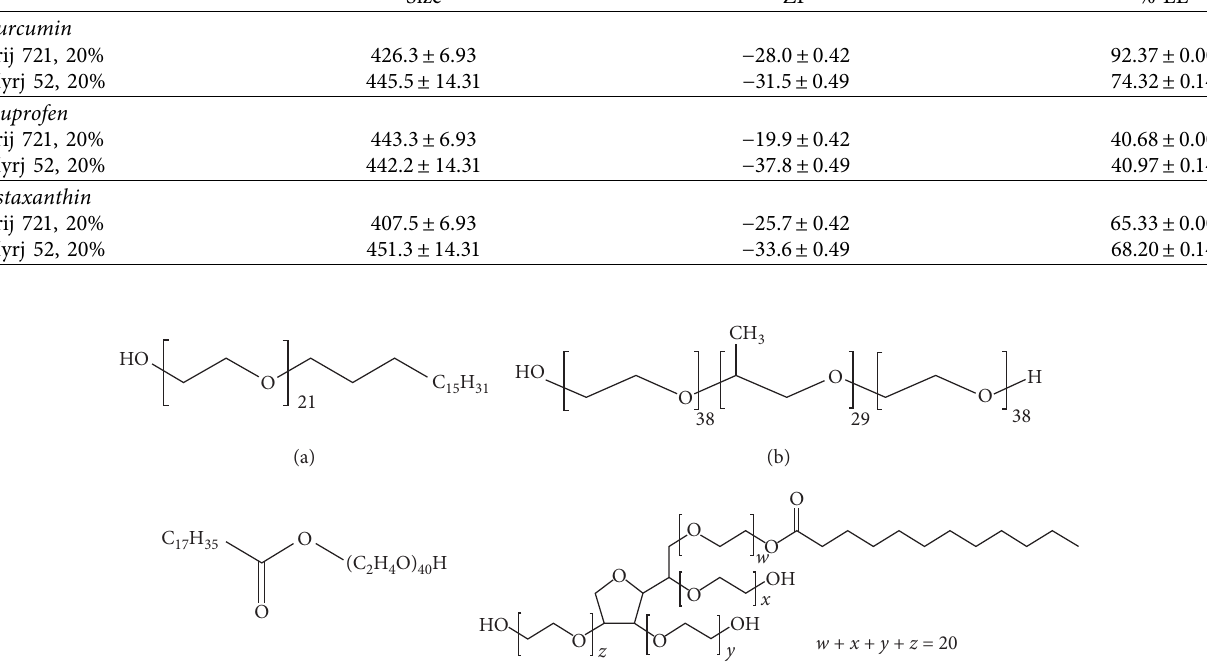
Figure 5: Physical properties of each surfactant. (a) Cremophor WO7, (b) Myrj 52, (c) Brij 721, (d) Tween 80, and (e) Poloxamer 188 (surfactant concentration 10%, 20%, and 30%). Table 5: The comparison of the particles of zeta potential and % entrapment efficiency ( n � 3). Size ZP % EE